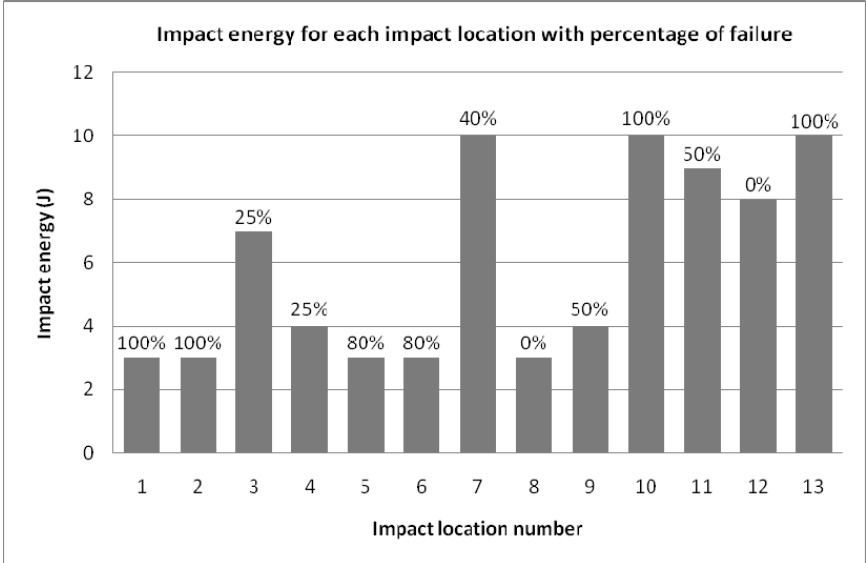
Figure 6. Percentage of failure for each impact location at different impact